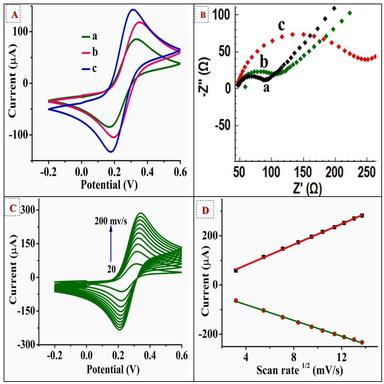
A) CV responses of GCE (a), GQDs@GCE (b), GQDs@La3+@ZrO2 (c) in 5 mM 3− /4− at 30 mVs− 1 scan rate; B) Nyquist plot of GCE (a), GQDs@GCE (b), GQDs@La3+@ZrO2 in 5 mM 3− /4− ; C) CVs at different scan rate (20–200 mVs− 1 ); D) Relationship between peak current and square root of the scan rate.